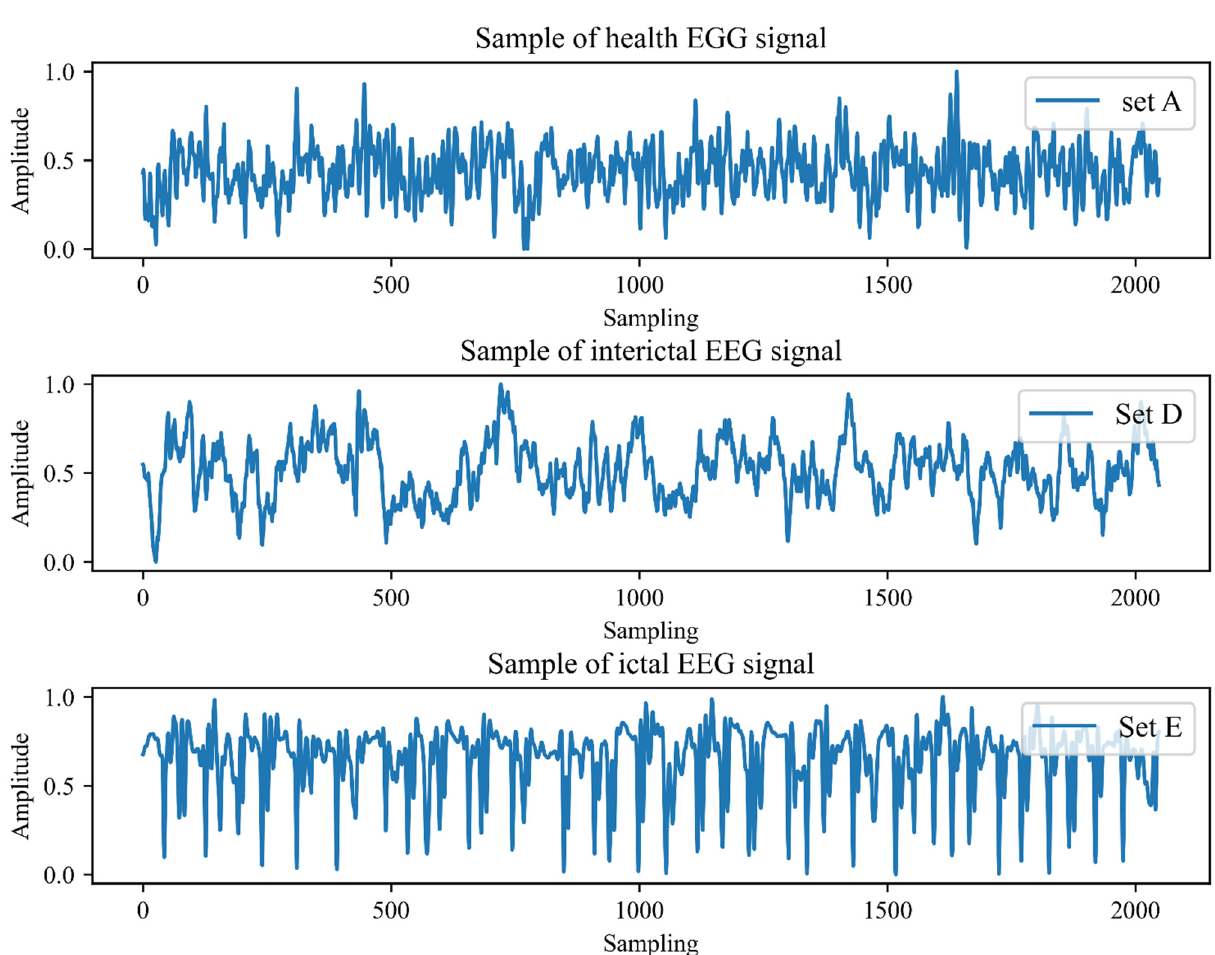
Figure 2. The normalized waveforms in the time domain for set A, set D, and set E.